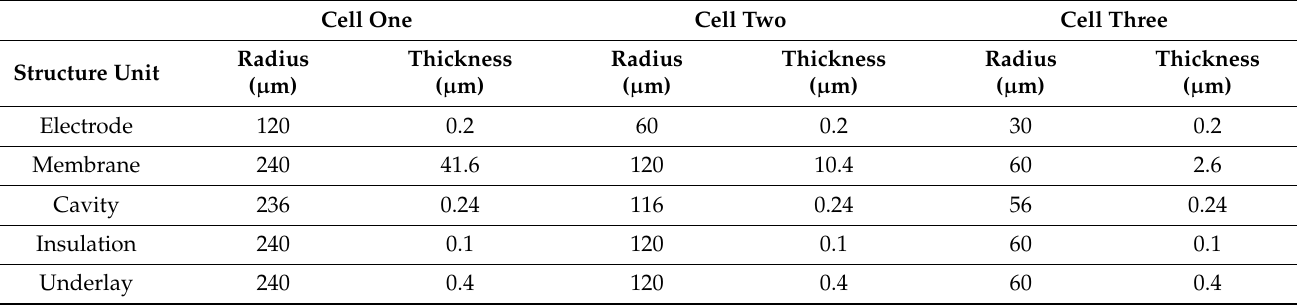
Table 2. CMUT cell structure